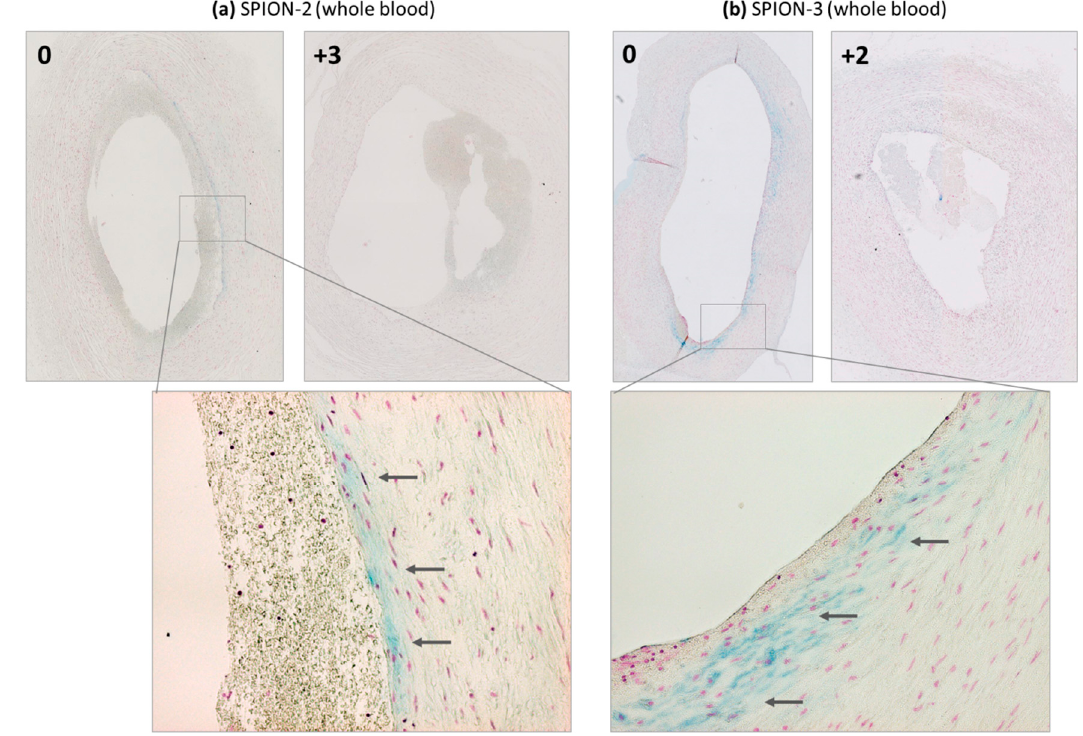
Figure 3. Detection of iron presence in arterial wall by histology. Magnetically targeted (segment 0) and representative control segments away from the tip of the magnet are shown for ( a ) SPION-2 and ( b ) SPION-3, suspended in the whole blood. Arrows indicate blue staining due to the particle accumulation.